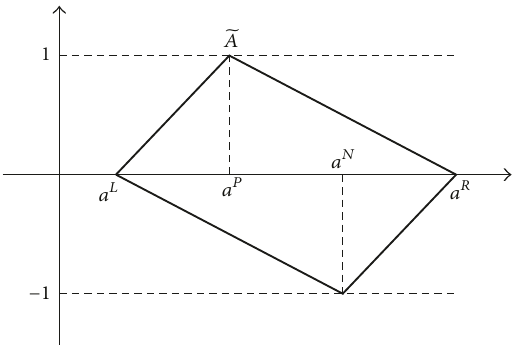
Figure 1: Triangular bipolar fuzzy number 𝑎 𝑃 ̸= 𝑎 𝑁